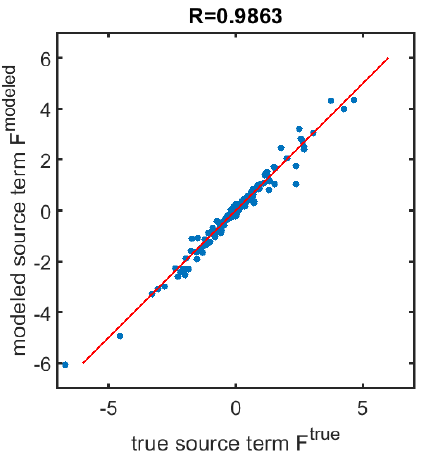
Figure 4. The predicted value of one component of the source term versus the true source terms (plotted in blue dots). The correlation coefficient is shown on the top of the frame. The 45 ◦ red line shows a perfect